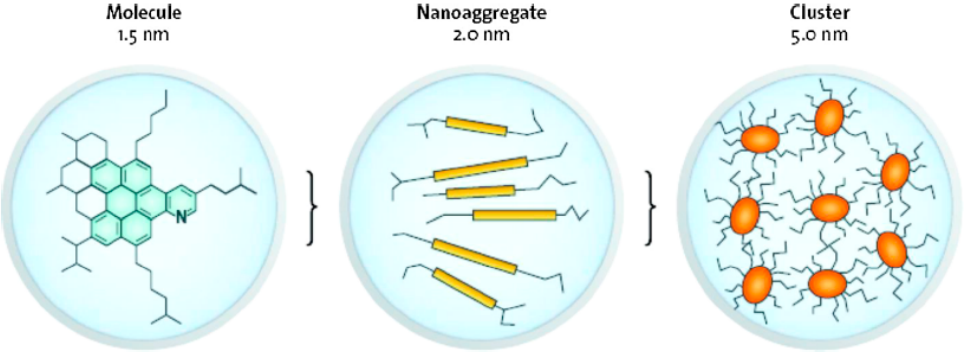
Figure 9. The molecular and colloidal structures of the Yen–Mullins model asphaltenes. Reprinted